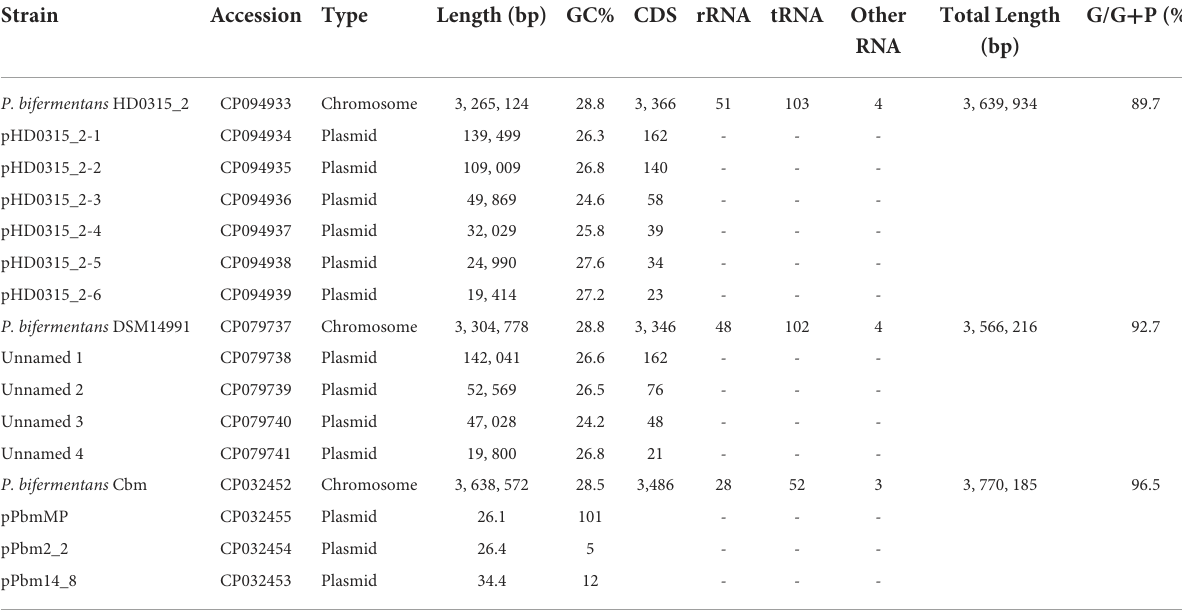
TABLE 1 Genomic features of the strains in the genus Paraclostridium with completed genome